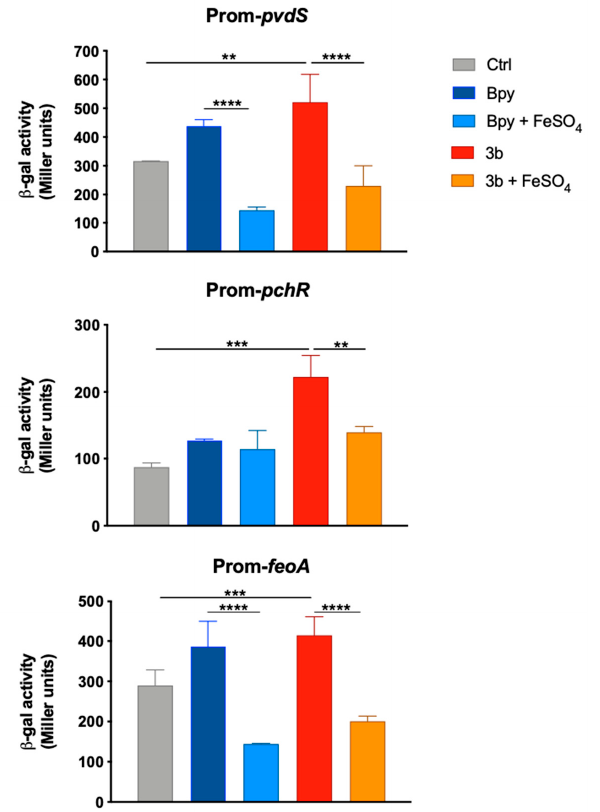
Figure 6. Transcriptional activity of pvdS , pchR and feoA promoters in PAO1. Wild type bacteria transformed with the pMP220 reporter carrying the promoter region of pvdS , pchR and feoA were grown in LB medium (Ctrl) supplemented with Bpy (0.2 mM) or compound 3b (0.2 mM), with or without FeSO 4 (0.2 mM) as indicated. Statistical significance (one-way ANOVA and Tukey’s multi- ple comparisons test): ** p < 0.01; *** p < 0.005 **** p < 0.0001.